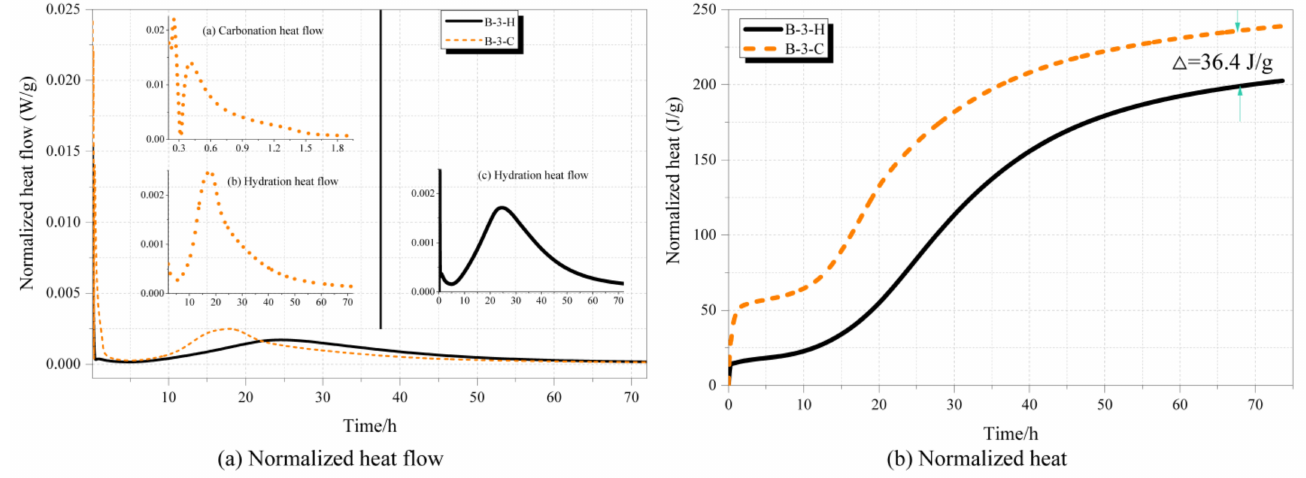
Figure 10. Normalized carbonation–hydration heat flow ( a ) and normalized heat ( b ) of B-3 sample.